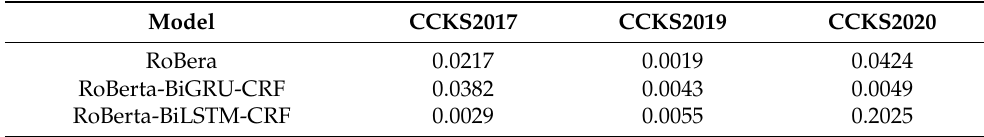
Table 7. Comparison results with different models on different